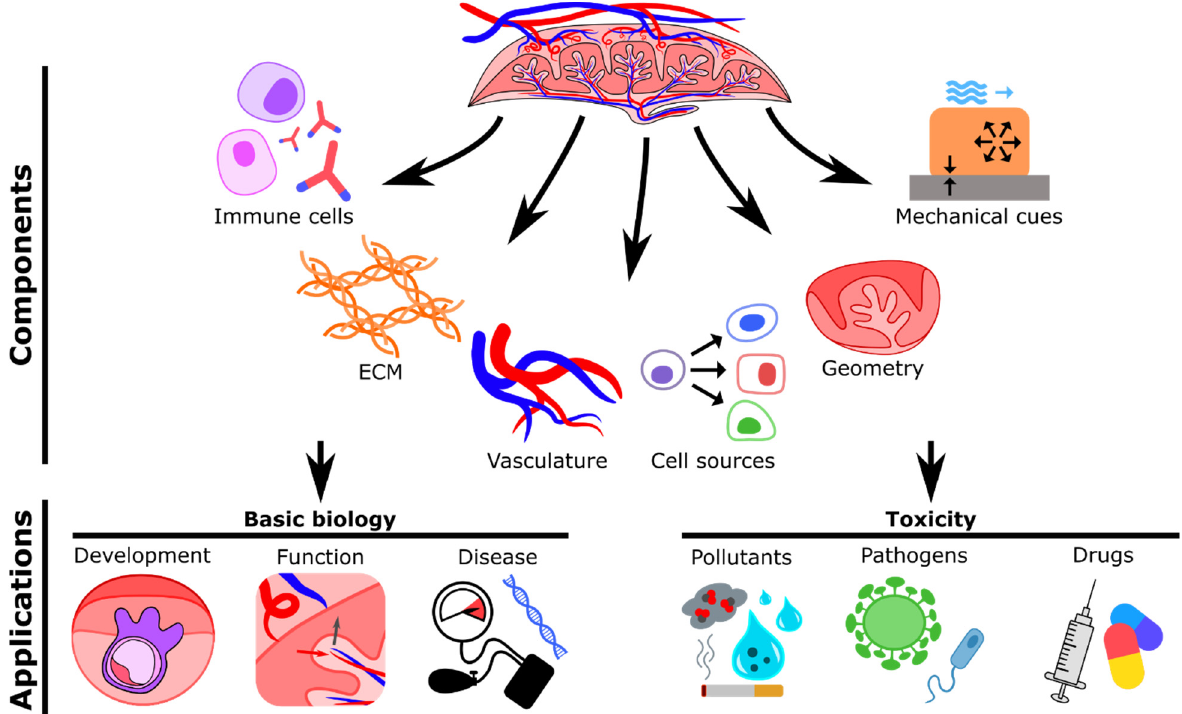
Figure 4. Summary of important components and possible applications of in vitro placental models. Immune cells may include Hofbauer cells or macrophages. Extracellular matrix (ECM) may be composed of collagen, laminin, fibronectin, or glycoproteins. Vascularization may be achieved via patterned microvessels, sacrificial molds, or self-assembled networks. Cell sources include cell lines, primary cells, or stem cells. Different geometries may be created by using 2D artificial membranes or two-photon polymerization (2PP). Relevant mechanical cues include fluid flow, matrix stiffness, and substrate stiffness. Possible applications in basic biology include studying the mechanisms of normal and pathological placental development and function. In vitro models may also be applied to study the transport and effects of pollutants, pathogens, and drugs.